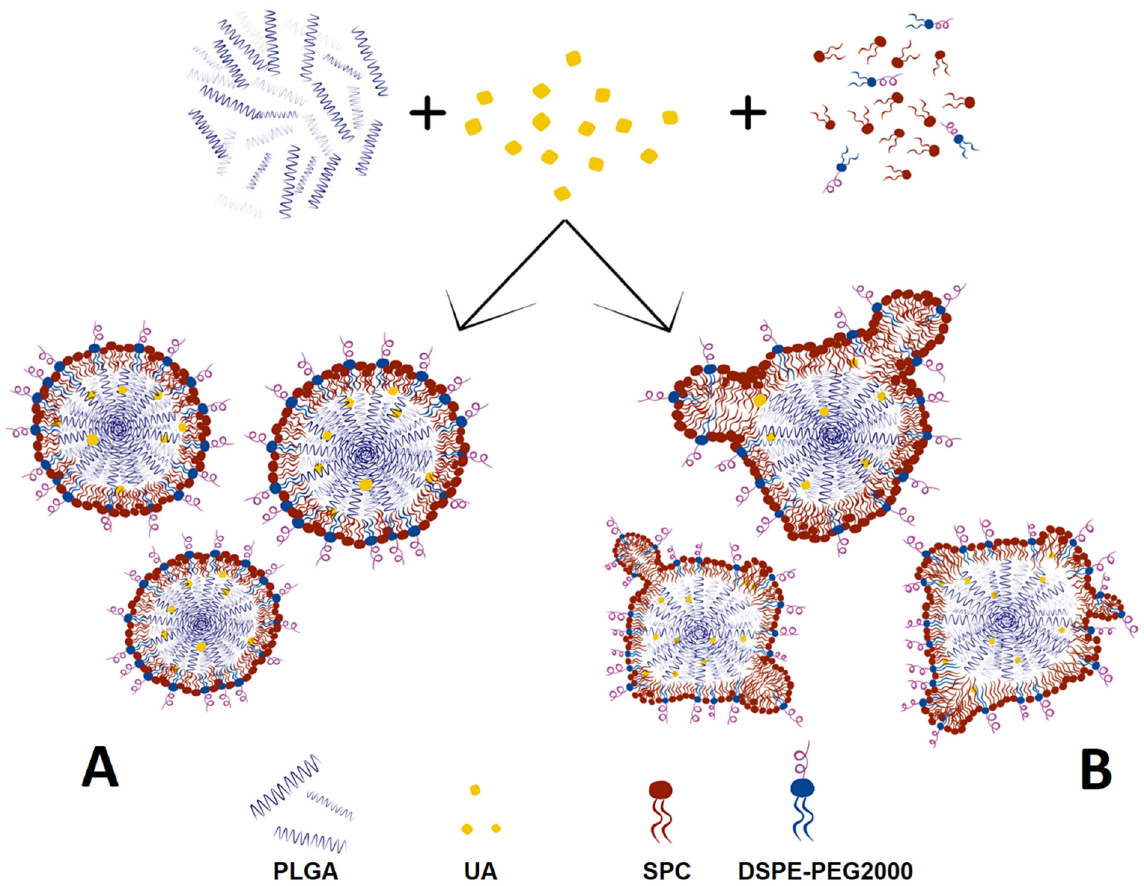
Figure 19. Comparison between the theoretical, “ideal” structure of UA-S85-PLGA-PEG 2000 nanoparticles ( A ) and that observed by TEM ( B ).